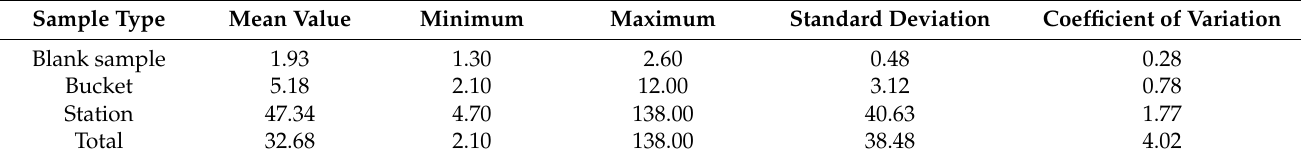
Table 4. Mercury content levels of the attachments in garbage containers (unit: ng/g).